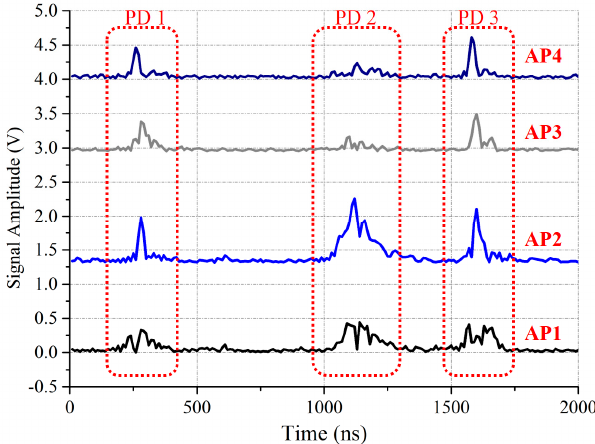
Figure 4. The digital envelope detection waveforms, which illustrate the PD interference phenomenon in the offline stage.